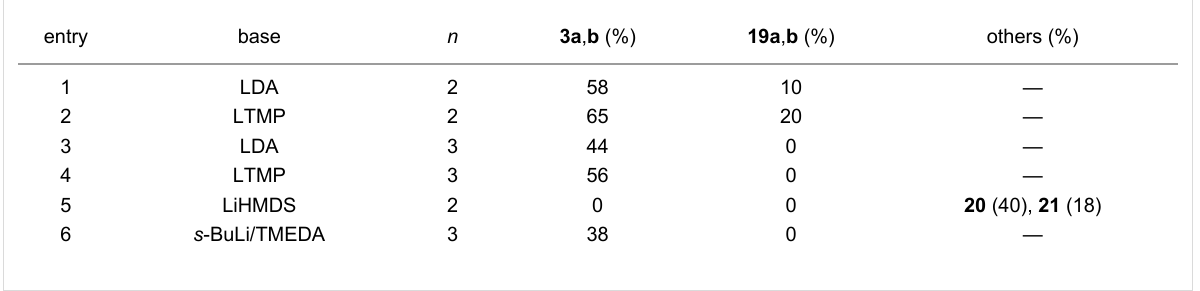
Table 1: Lateral lithiation/alkylation of 6-methyluridine 2